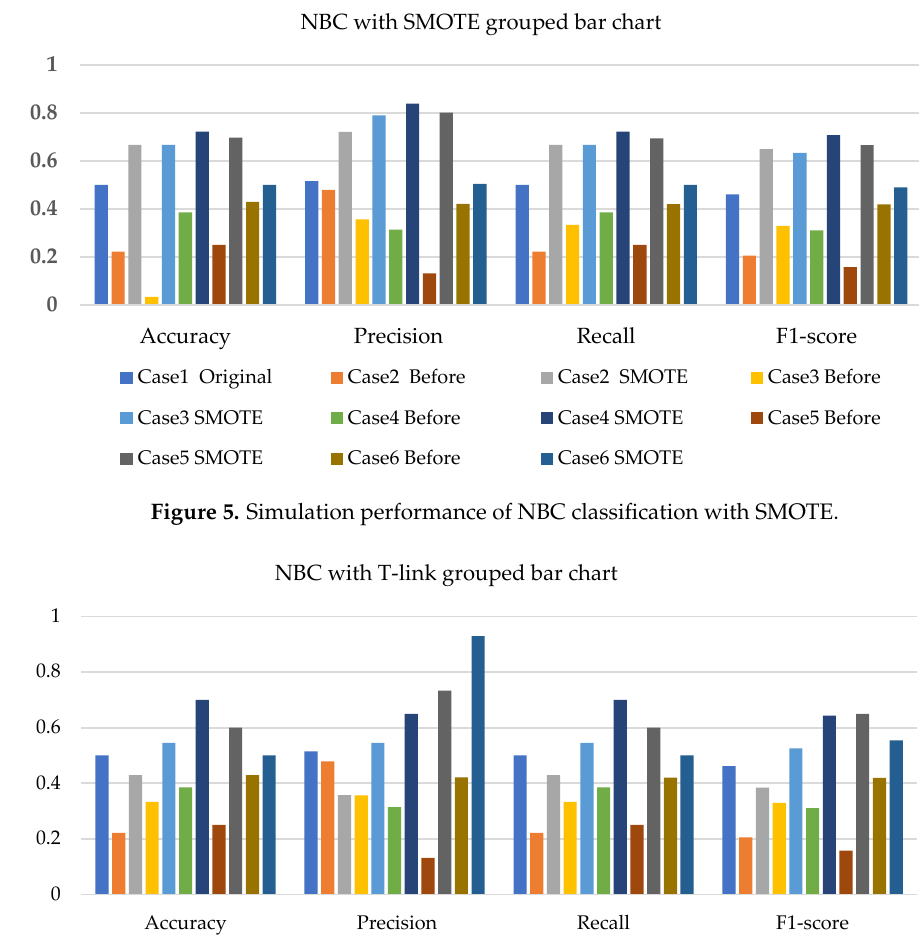
Figure 7. Simulation performance of NBC classification with SMOTE/T-link. Figures 8–10 present the SVM with SMOTE, SVM with T-link, and SVM with a com- bination of SMOTE/T-link. The SVM with SMOTE presents the best data level cases per- formance with slight improvements. Data level cases 3 and 6 show performances below the SVM without SMOTE with 17.7% and 21%—accuracy and recall; 14.3% and 21.1%— precision; and 10.79% and 12.8%—F1-score, respectively. The SVM with SMOTE has a minimum accuracy of 36% and a maximum of 58%. The SVM with T-link shows improve- ments in each case, with case 5 being the lowest, which performs with 0.6—accuracy and recall; 0.55—precision; and 0.543—F1-score. Case 6 shows the best performance with 0.786—accuracy and recall; 0.764—precision; and 0.728—F1-score. The SVM with T-link